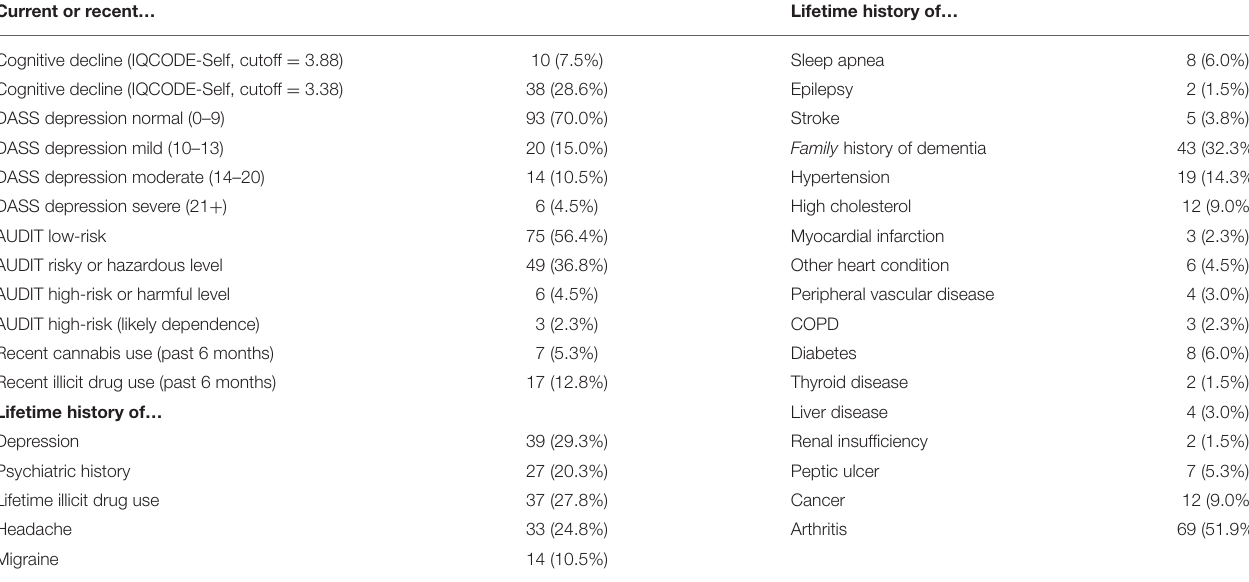
TABLE 3 | Past and present health problems. Current or